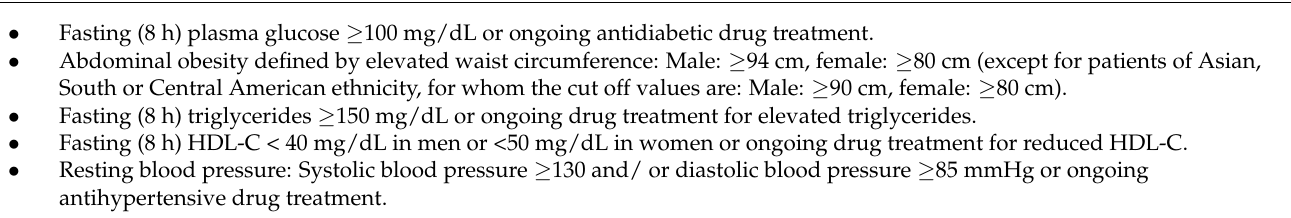
Table 1. Definition of metabolic syndrome